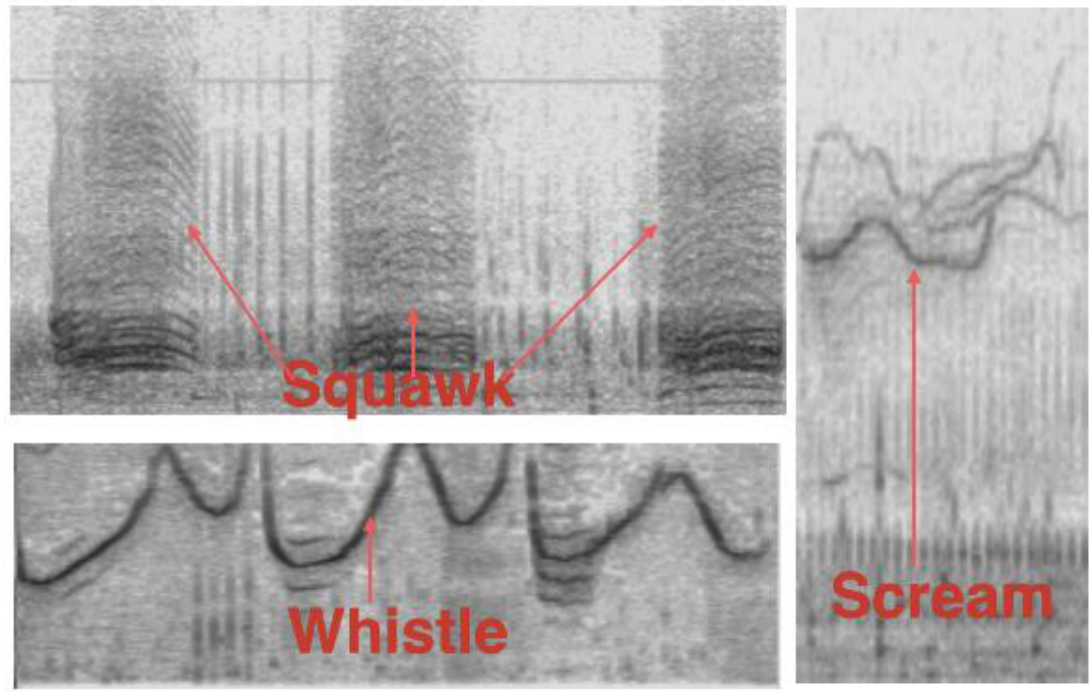
Figure 5. Different audible dolphin communication